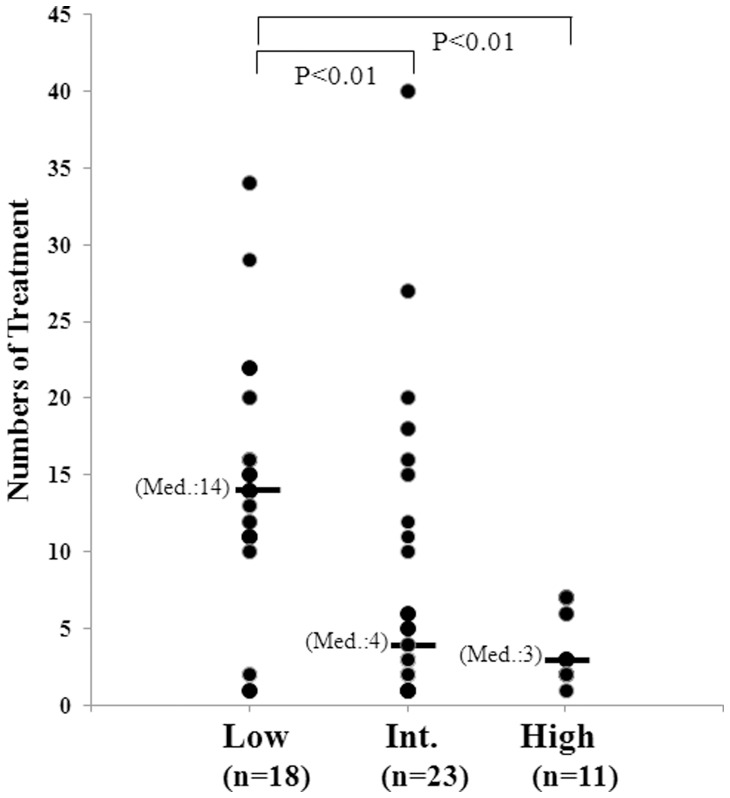
Docetaxel treatment number in each risk group with long-term treatment.The low risk group showed significant differences compared with the intermediate and high risk groups (P<0.01).